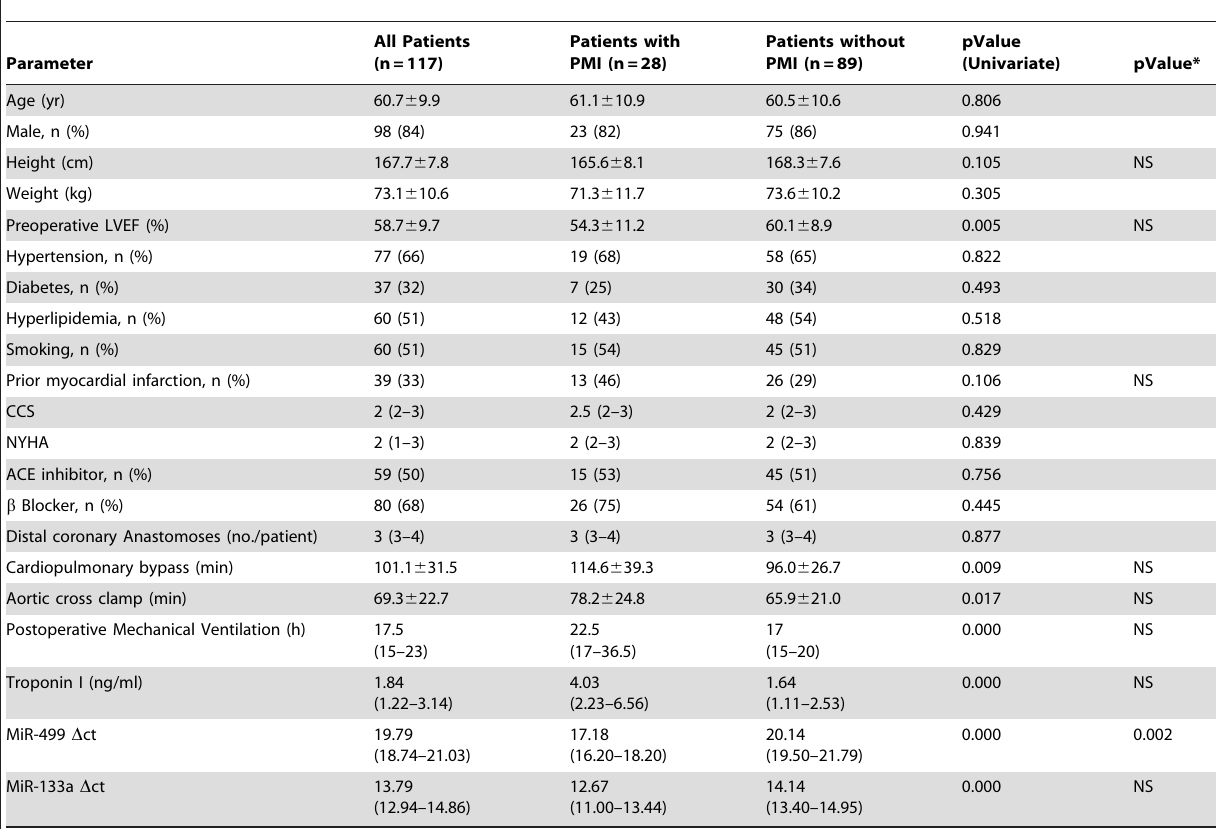
Table 2. Demographic and Perioperative Characteristics of Enrolled